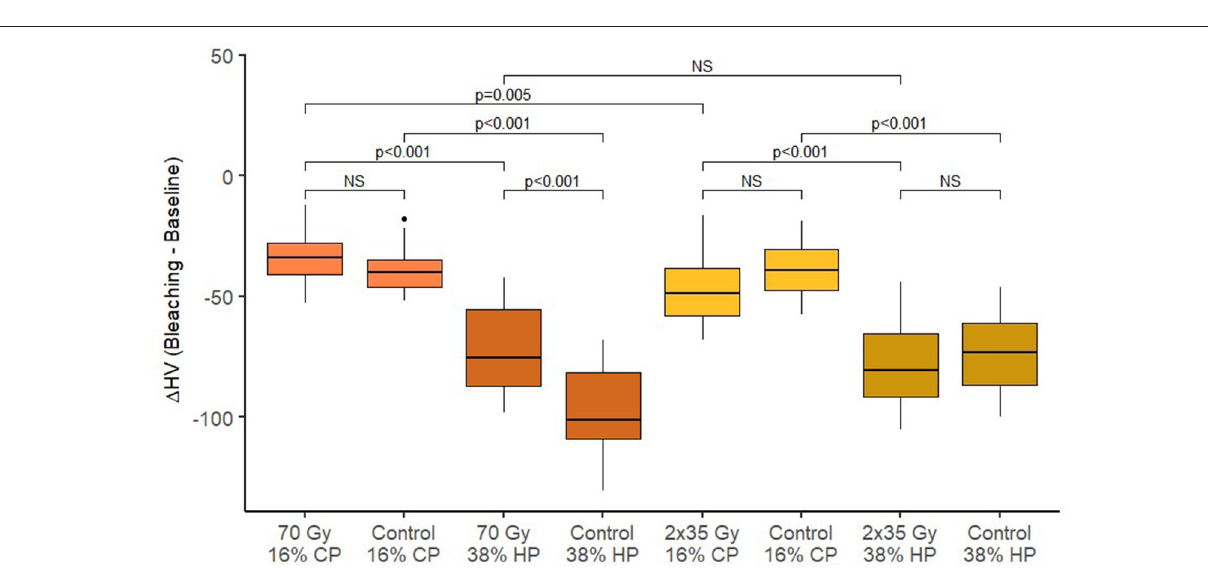
FIGURE 4 | Box plots of changes in dentin Vickers microhardness after bleaching across different treatment